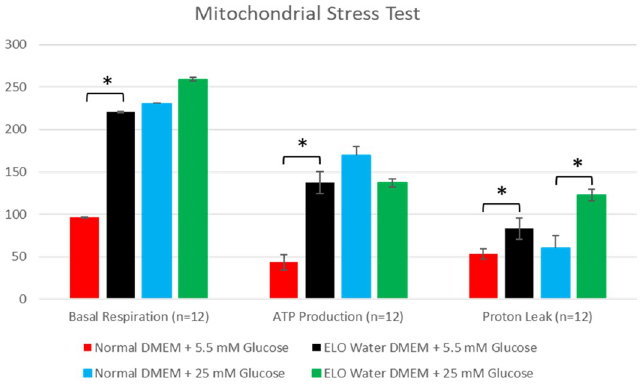
Fig 4. Mitochondrial stress test: Oxygen consumption rates in HepG2 cells cultured in ELO water- and or control (regular) water-based media at normal (5.5 mM)- or high (25 mM)-glucose concentrations. Significant differences between OCRs linked to basal respiration, ATP production and proton leak are indicated by � = p < 0.01.